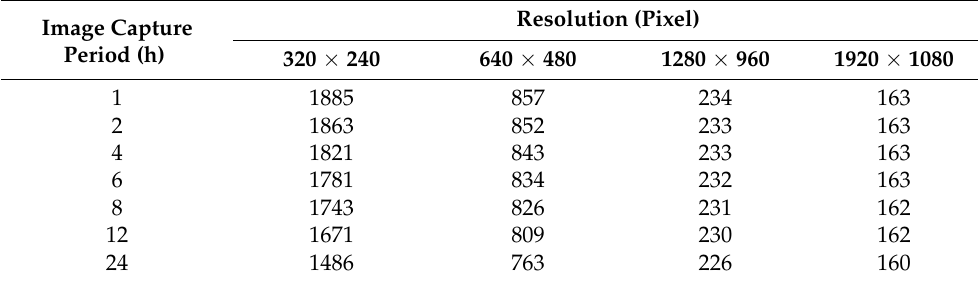
Table 3. Number of images captured at different resolutions and capture